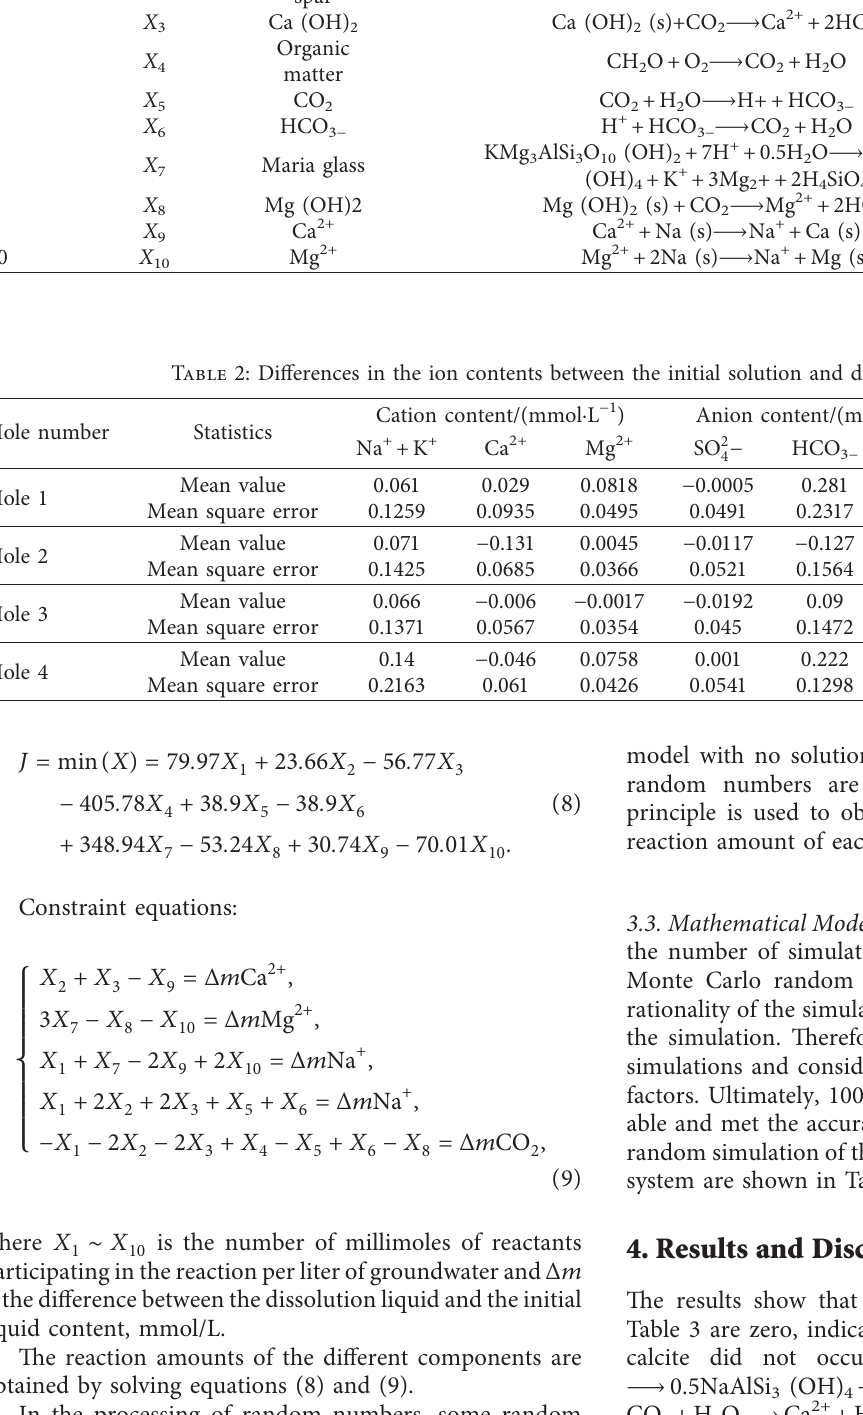
Table 1: Physicochemical reactions and free energy change ( Δ G